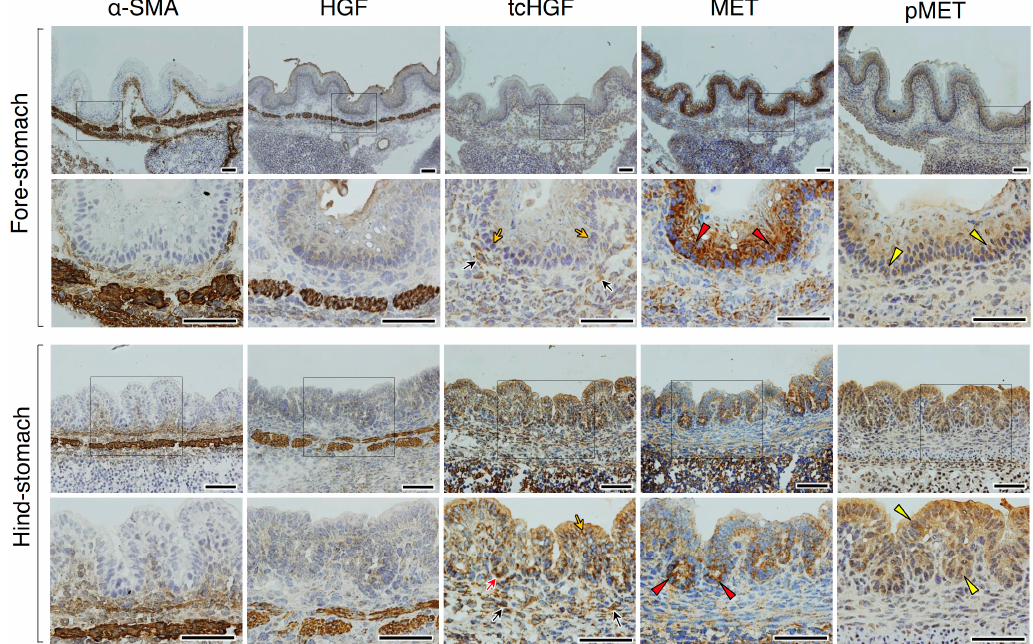
Figure 4. Localizations of HGF, tcHGF, MET, and phosphorylated MET (pMET) in the developing stomach. Immunohistochemical staining was performed using t5A11 (for scHGF and tcHGF), t8E4 (for tcHGF), anti-MET, or anti-phospho-MET antibody. The fore-stomach and hind-stomach were respectively characterized by multilayered squamous epithelia and developing glandular epithelium. Black and yellow arrows indicate tcHGF localized in the sub-epithelial and epithelial cells, respectively. The red arrow indicates strong tcHGF localization in developing glandular regions. Red arrowheads indicate strongly MET-positive cells in the epithelial cells. Yellow arrowheads indicate pMET in epithelial cells. The images in the lower panel are magnified images of the boxed areas in the upper panel. Similar immunohistochemical localization patterns were obtained in sections from two different mice. Tissues were obtained from day 16.5 embryos of hHGF-ki mice. Scale bars represent 200 µm.